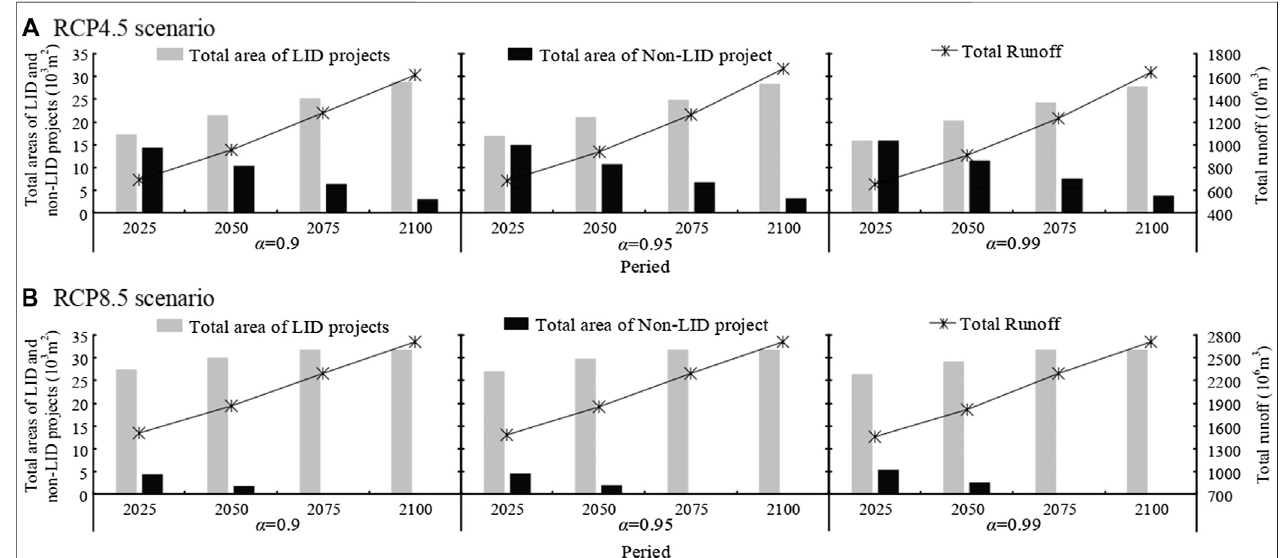
Frontiers in Earth Science |